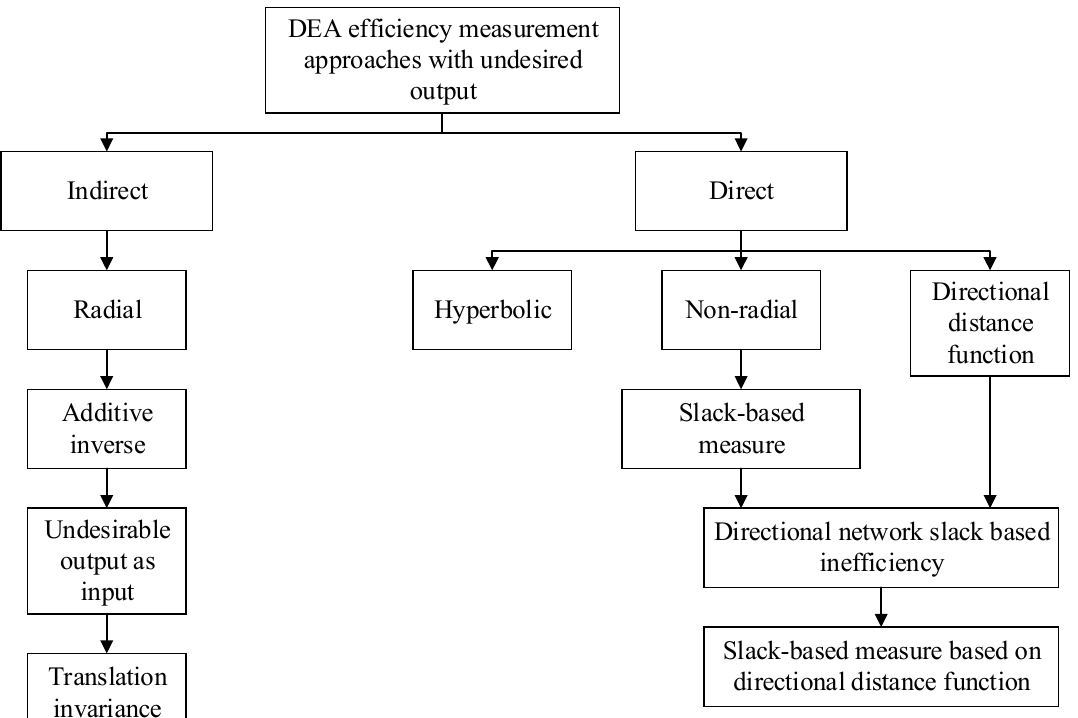
A structure of Data Envelopment Analysis (DEA) e ffi ciency measurement with undesired